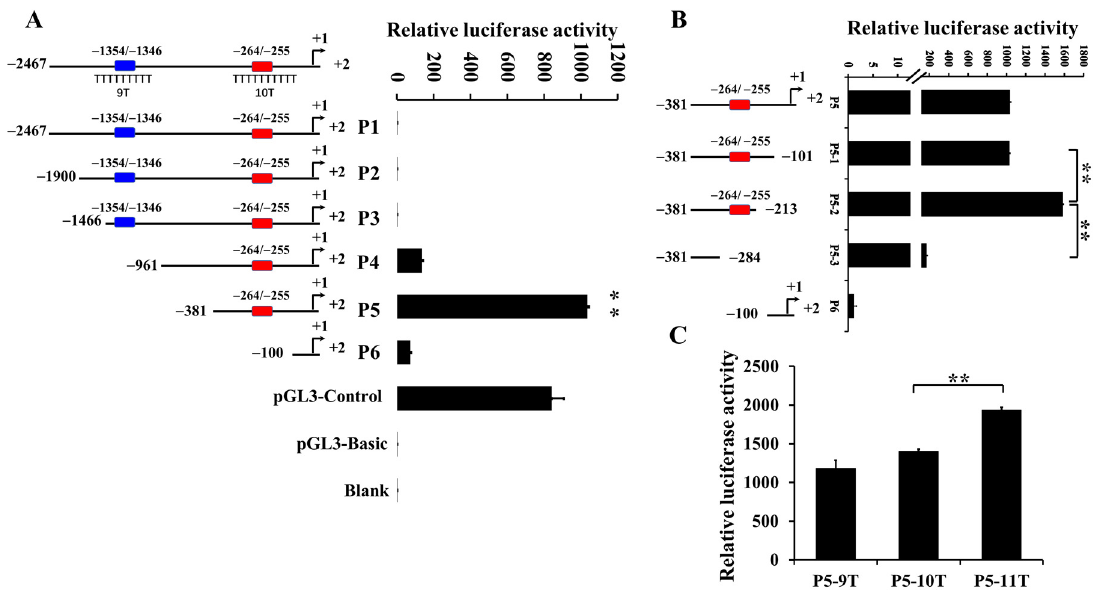
Figure 1. Analysis of poly(dA:dT) tracts on IGF1 promoter activity in pigs. Luciferase report vectors containing various lengths of the IGF1 promoter region were constructed and transfected into porcine fetal fibroblast cells. ( A ): Analysis of poly(dA:dT) tracts on IGF1 transcription activities detected using luciferase assay. Tract 1: ( − 1354/ − 1346); tract 2: ( − 264/ − 255); blank: untreated cells; pGL3-Basic: negative control; pGL3-Control: positive control; ( B ): Effect of tract 2 on IGF1 transcription activity. ( C ): Detection of the transcription activities of different genotypes of tract 2 on IGF1 . Data were presented as mean ± sd. The data shown were three independent experiments. A two tailed t -test was used to determine the statistical significance of the difference between the promoter constructs, and ** was annotated as p <